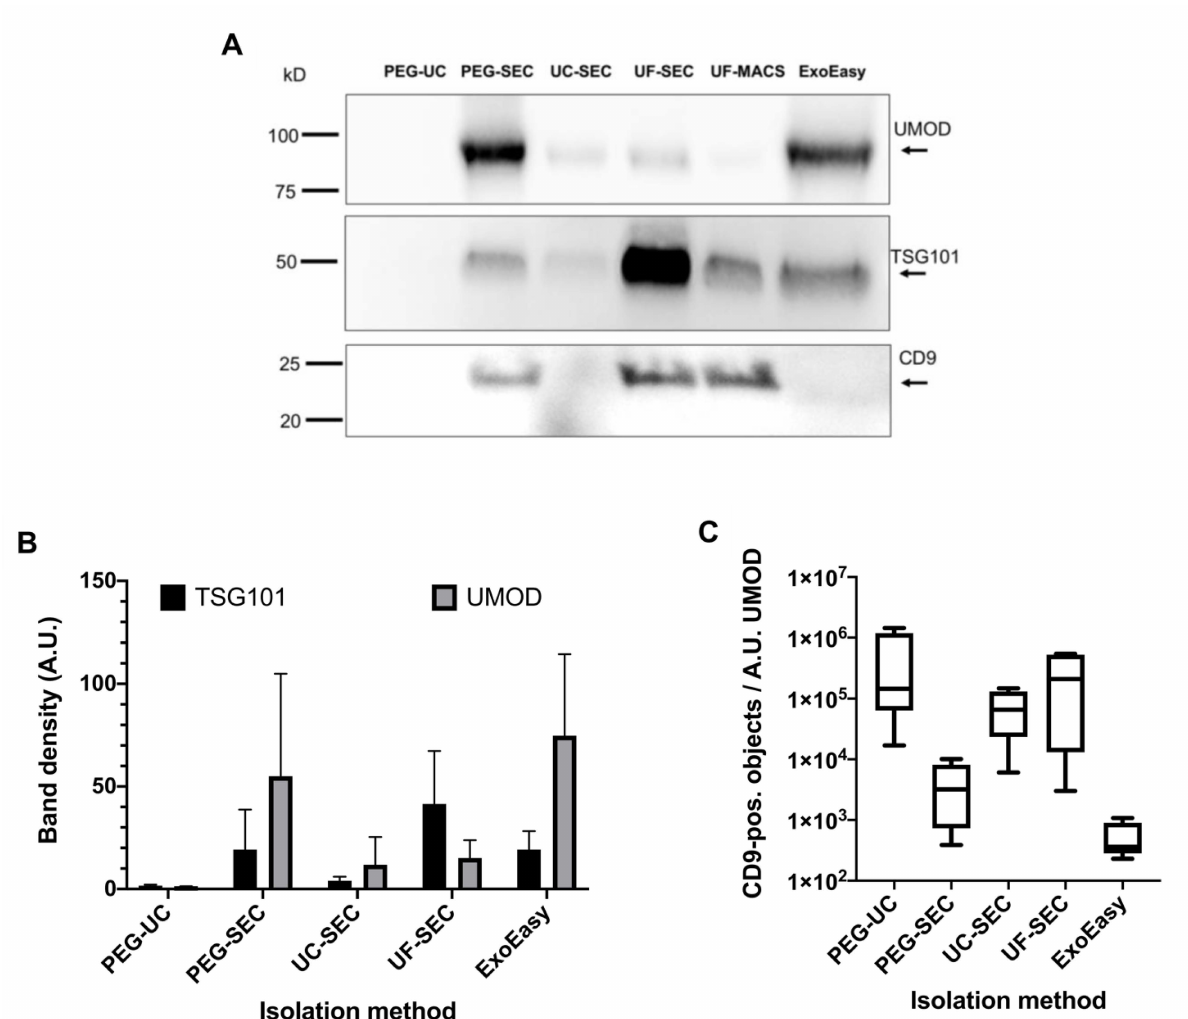
Figure 5. The UF-SEC method outcompetes other techniques in terms of EV protein marker recovery and purity. ( A ) Western blot results of one of the processed void urine samples performed on freshly obtained uEV samples. Sample loading was adjusted to volume equivalents of the initial void urine sample. The uEV samples were separated under reducing and non-reducing conditions. The Western blot performed under reducing conditions was probed with anti-TSG101 and anti-UMOD antibodies. The Western blot performed under non-reducing conditions was probed with anti-CD9 antibodies. Bands were visualized after counterstaining with HRP-conjugated secondary antibodies and addition of chemiluminescent HRP substrate. ( B ) Comparison of average TSG101 and UMOD band intensities of all uEV samples arranged according to the applied purification method. All samples were stored at − 80 ◦ C before Western blot analysis, images of all relevant Western blots are shown in Supplementary Figure S3. Error bars indicate the standard deviation. ( C ) Average sample purities are calculated as the ratio of CD9-positive objects to the average UMOD band